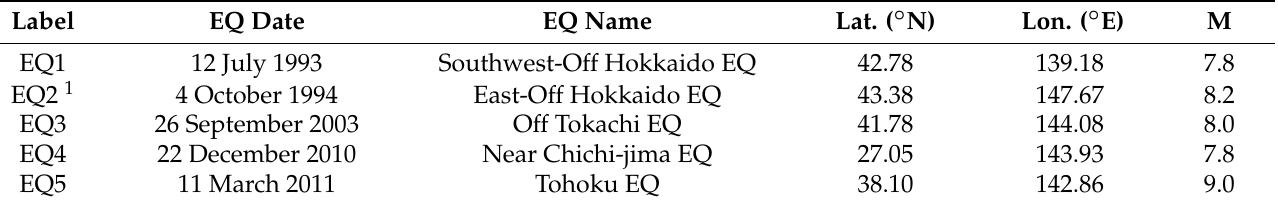
Table 1. All M JMA ≥ 7.8 EQs since 1 January 1984 until the M 9 Tohoku EQ on 11 March 2011 in the larger area N 46 E 148 . Reproduced under permission from Ref. [44]. ©2014. American Geophysical 25 125